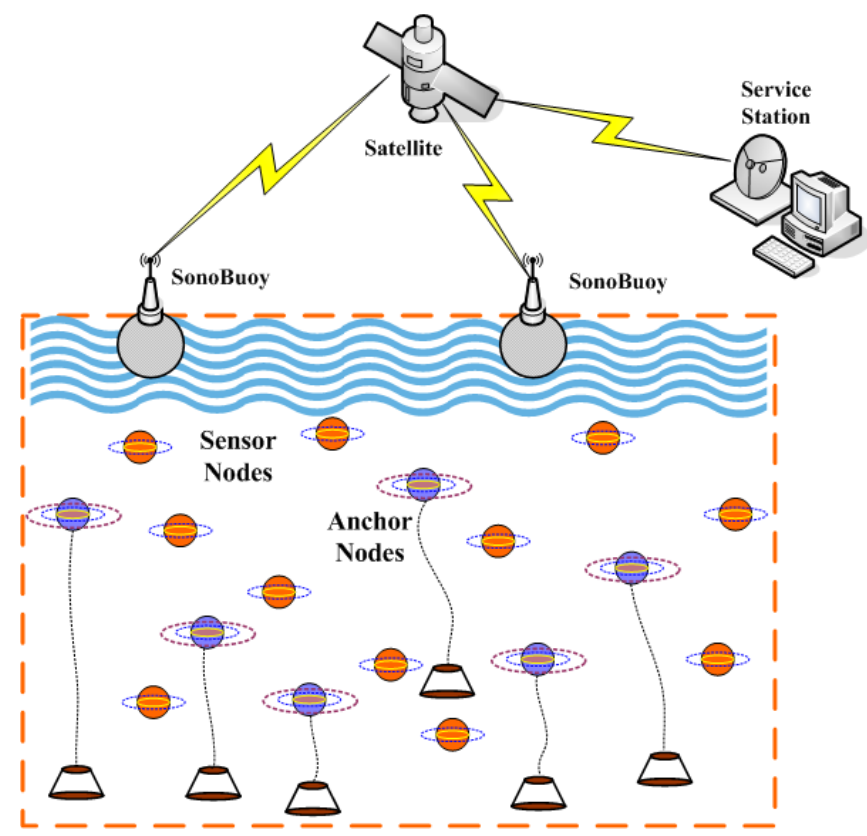
Figure 1. Localization topology of three-dimensional underwater sensor